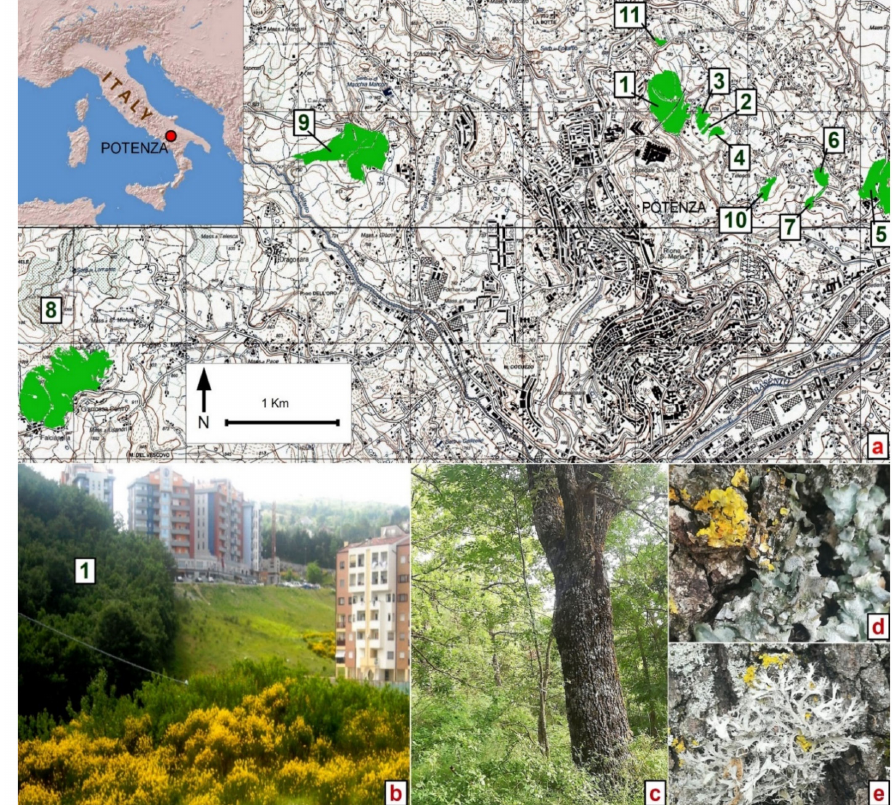
Figure 1. ( a ) Study area location: green patches are the 11 peri-urban Quercus pubescens woodlands sampled to assess their epiphytic lichens diversity and composition; forest patch numbers correspond to those in Table 1; ( b ) new urban areas in the periphery of Potenza city (Macchia Romana) close to the forest patch number “1” with flowering of Spartium junceum shrubs, which are recolonizing uncultivated areas; ( c ) Quercus pubescens tree at Macchia Giocoli (patch n. 8); ( d ) Pleurosticta acetabulum (Neck.) Elix & Lumbsch and Xanthoria parietina (L.) Th. Fr. on Q. pubescens ; ( e ) Anaptychia ciliaris